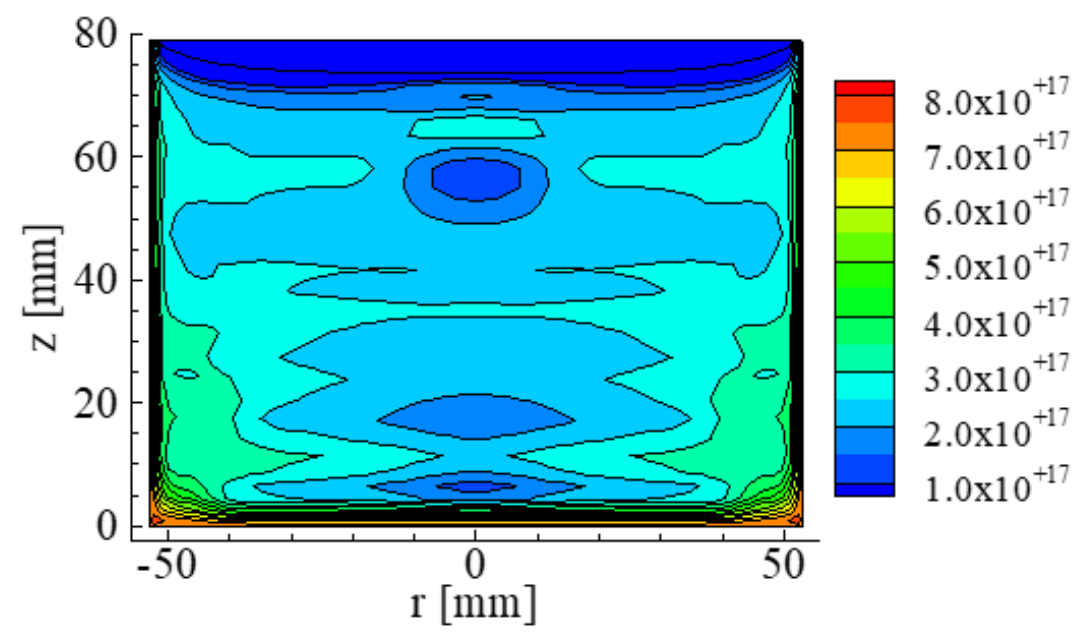
Figure 8. Concentration distribution of O in a Si crystal and the melt. The unit of concentration is atoms/cm 3 . Reproduced using data from reference [17].